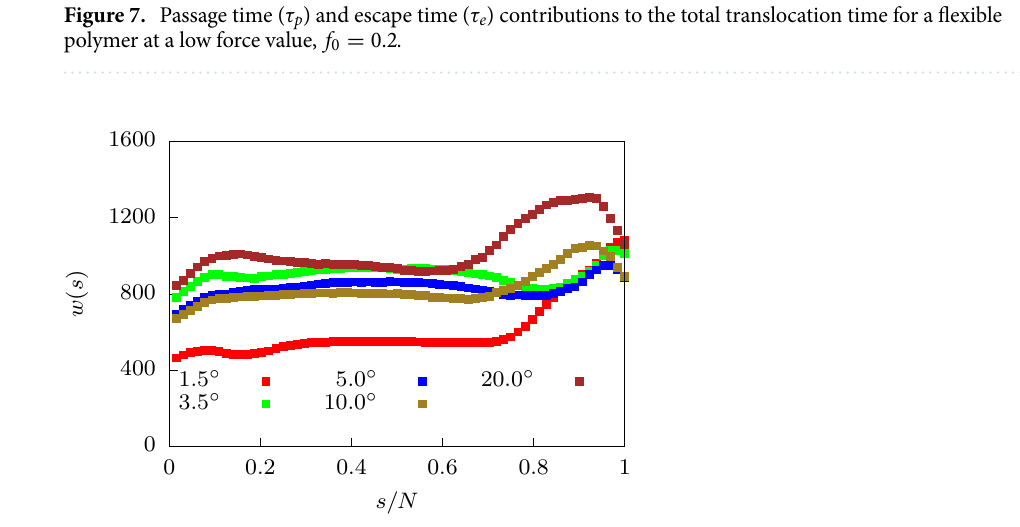
Figure 8. Waiting time distributions ( w ( s )) of a flexible polymer for different α for f 0 = 0.2